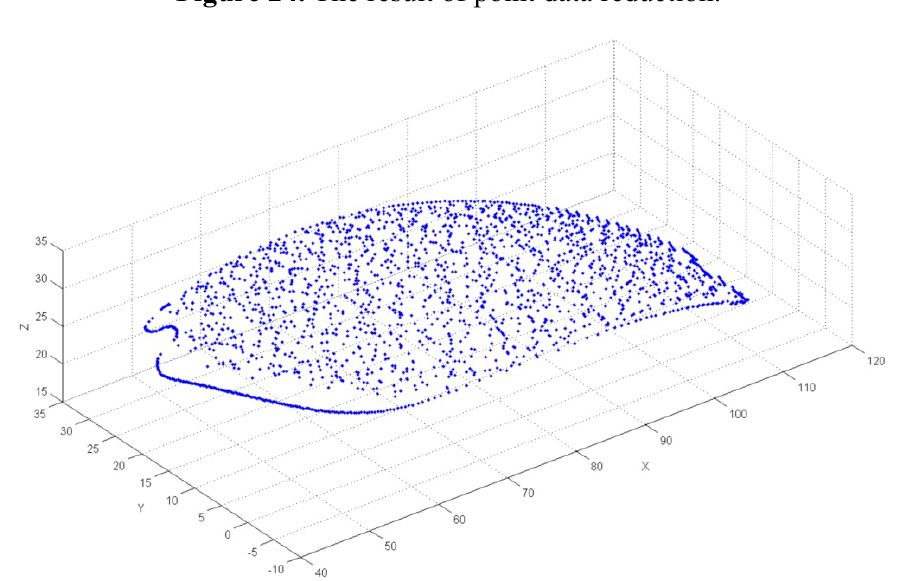
Figure 24. The result of point data reduction.